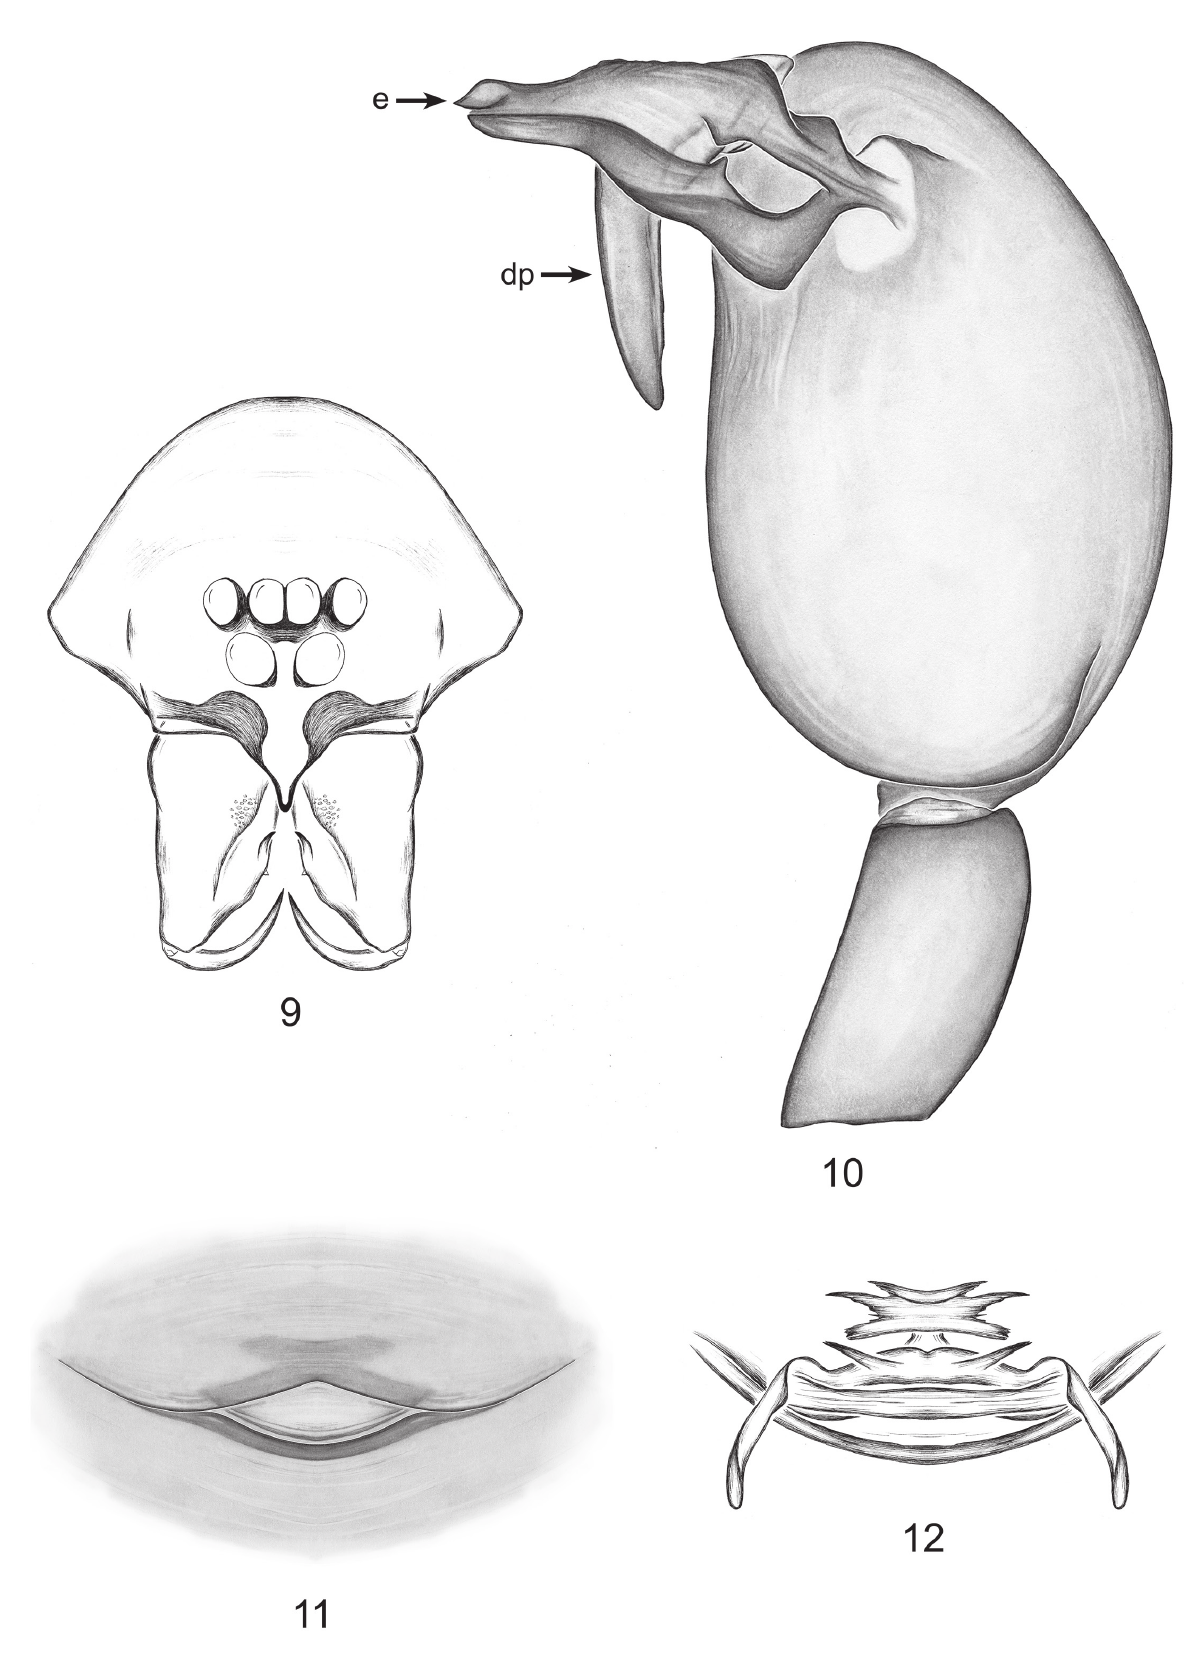
11. Epigynal region, ventral view. 12. Internal genitalia, dorsal